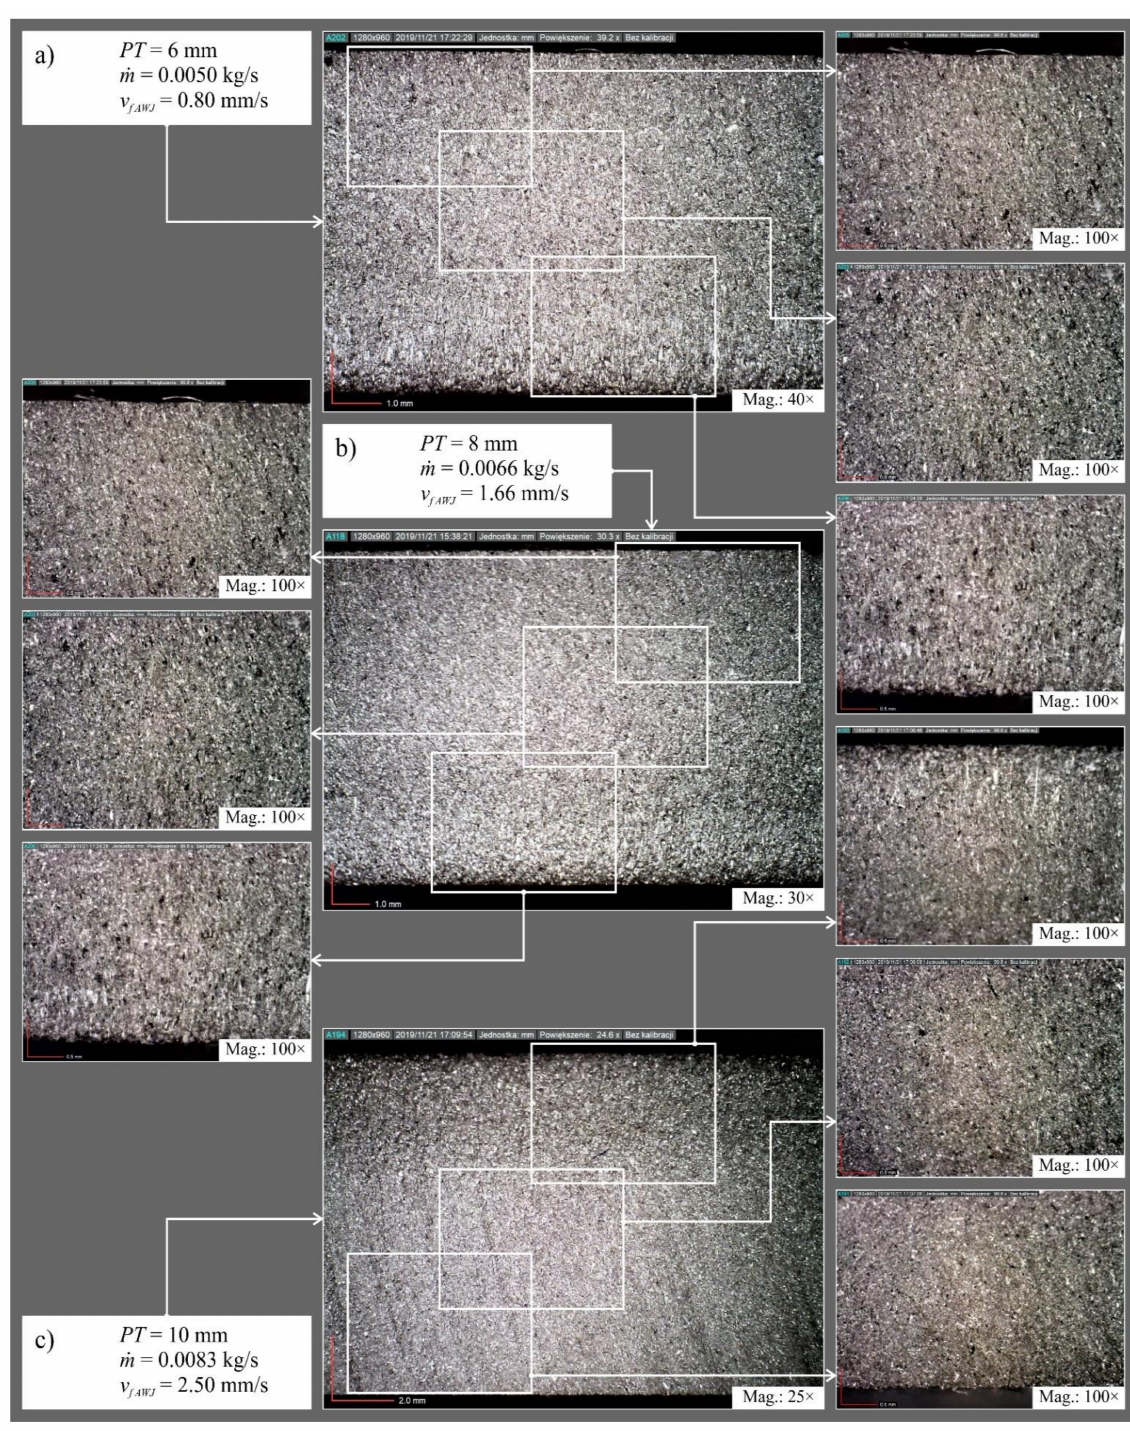
Figure 7. Examples of microscopic images of surfaces after abrasive water jet cutting: ( a ) PT = 6 mm, ˙m = 0.0050 kg/s, v f AWJ = 0.80 mm/s; ( b ) PT = 8 mm, ˙m = 0.0066 kg/s, v f AWJ = 1.66 mm/s; ( c ) PT = 10 mm, ˙m = 0.0083 kg/s, v f AWJ = 2.50